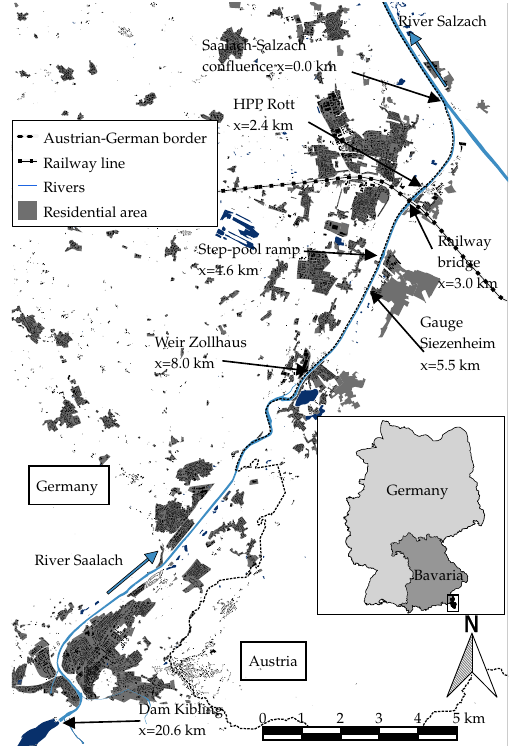
Figure 1. Overview on the study area (Adapted from